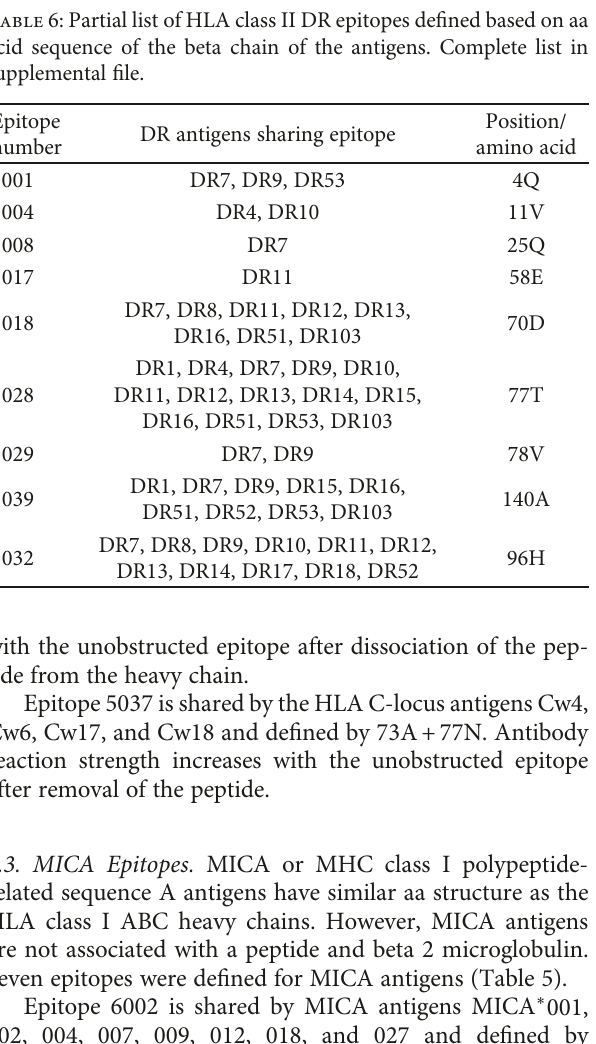
Figure 11: Epitope 1028 shared by class II DR antigens DR1, DR4, DR7, DR9, DR10, DR11, DR12, DR13, DR14, DR15, DR16, DR51, DR53, and DR103 and de fi ned by threonine (T) at position